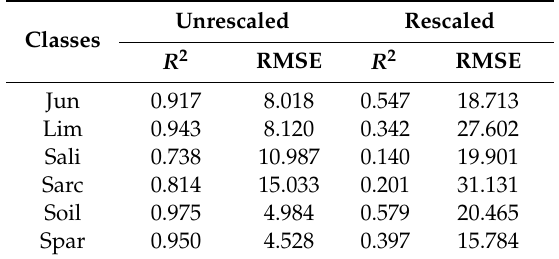
Table 4. Accuracy information for RF regression. Jun = Juncus , Lim = Limonium , Sali = Salicornia , Sarc = Sarcocornia and Spar = Spartina